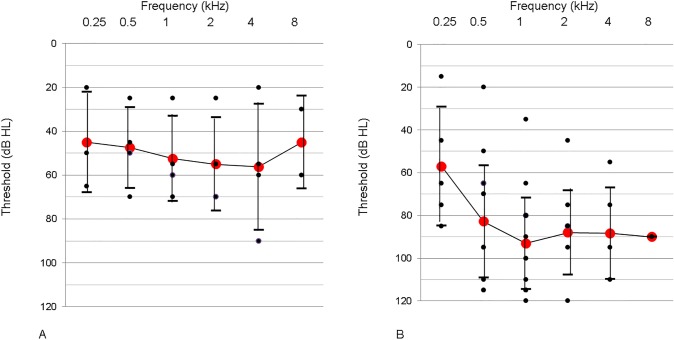
Overlapping audiograms of the patients with p.V37I and non-p.V37I GJB2 mutations.A. Patients with hearing loss caused by a p.V37I mutation (n = 4). B. Patients with hearing loss caused by a non-p.V37I mutation (excluding patients with a p.V37I mutation in the trans configuration) (n = 18). (Black dots mean hearing thresholds of each subject, which may represent more than one subject with identical hearing thresholds. Red dots represent mean hearing thresholds of each frequency).